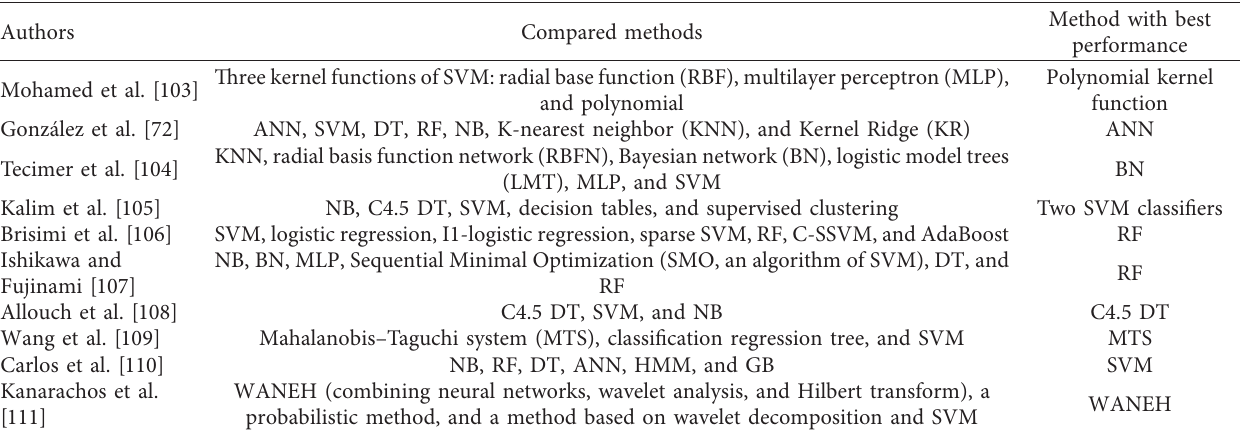
Table 4: Research studies that compared SVM to other